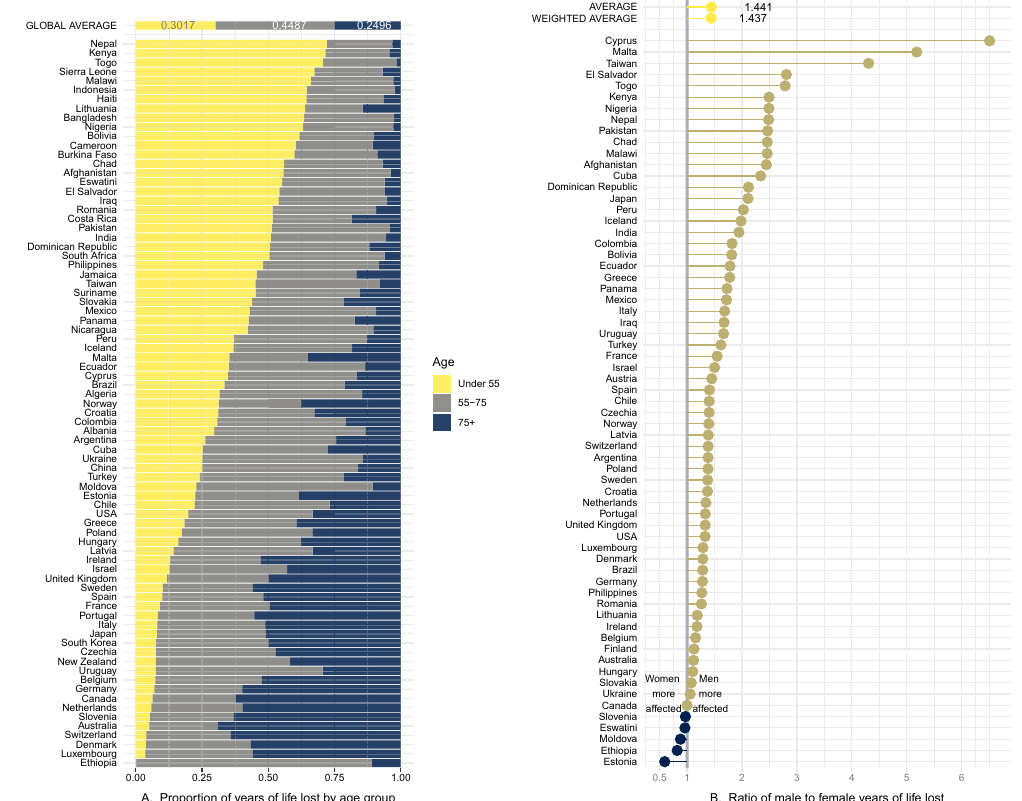
Figure 2. Panel A displays the country-specific proportions of YLL traced back to each age group. The global average proportion is presented at the top, and countries are in decreasing proportion of YLL in the under 55 age bracket. Panel B reports the ratio of male YLL rates to female YLL rates for countries with available gender specific COVID-19 death counts. Countries with genders equally affected by YLL rate are closer to the parity line at 1, while countries with women more affected have points lying on the left; countries with men more severely affected display points lying to the right. Global average and global weighted average of male to female YLL are presented at the